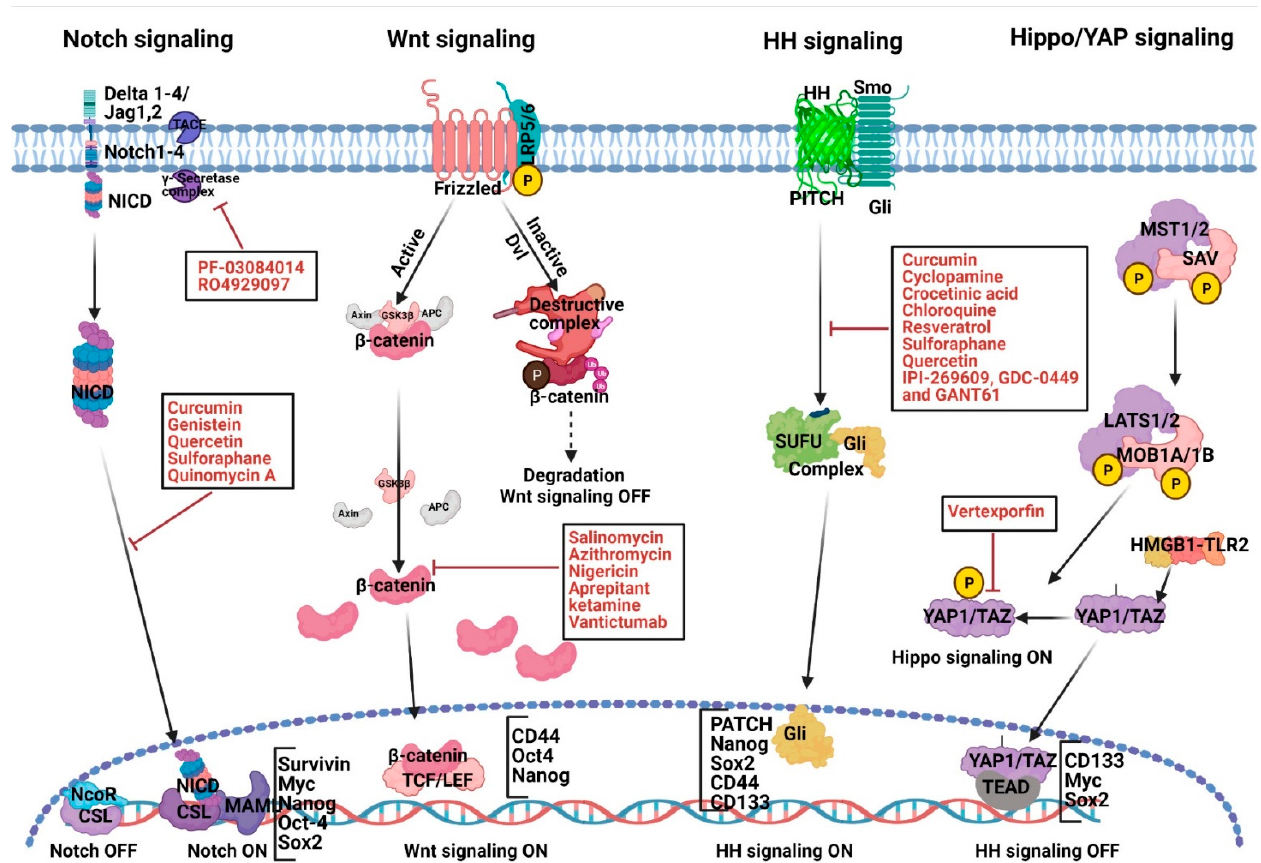
Figure 2. A schematic representation of major signaling cascades in normal stem cells vs. pancreatic cancer stem cells and their therapeutic strategies. Jagged1,2 (JAG1,2); Notch intracellular domain (NICD); Low-density lipoprotein receptor- related protein 5/6 (LRP5/6); Dishevelled (Dvl); Adenomatous polyposis coli (APC); T-cell factor/lymphoid enhancer factor (TCF/LEF); Hedgehog (Hh).